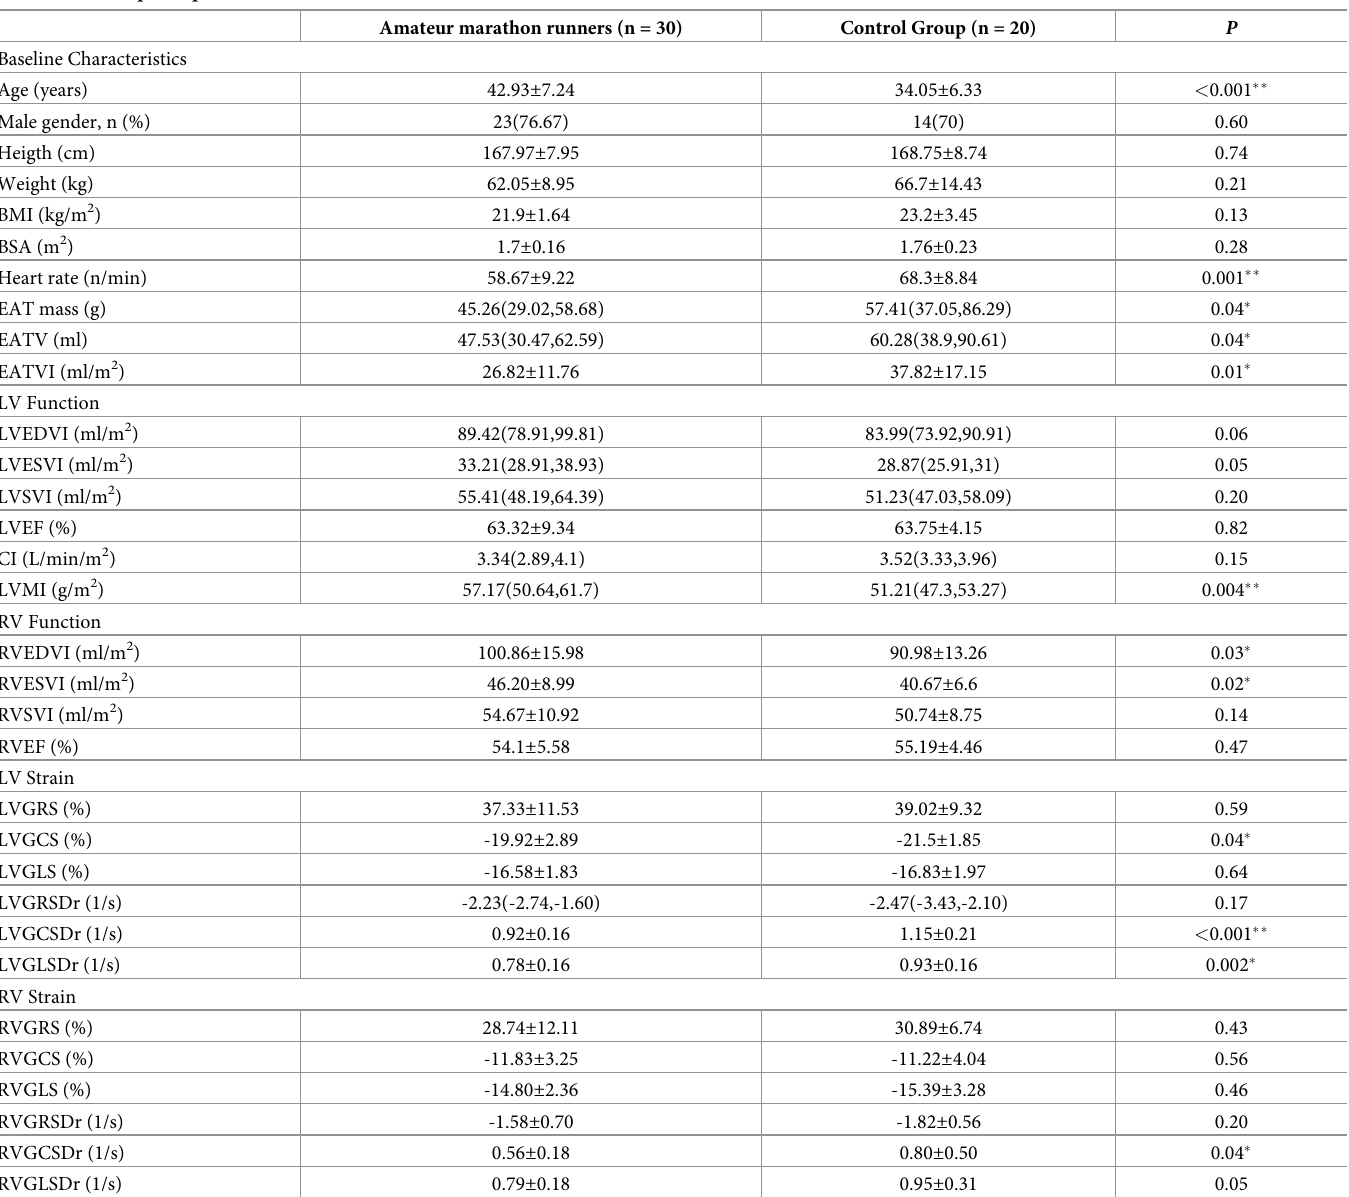
Table 2. Overall participants’ baseline characteristics and